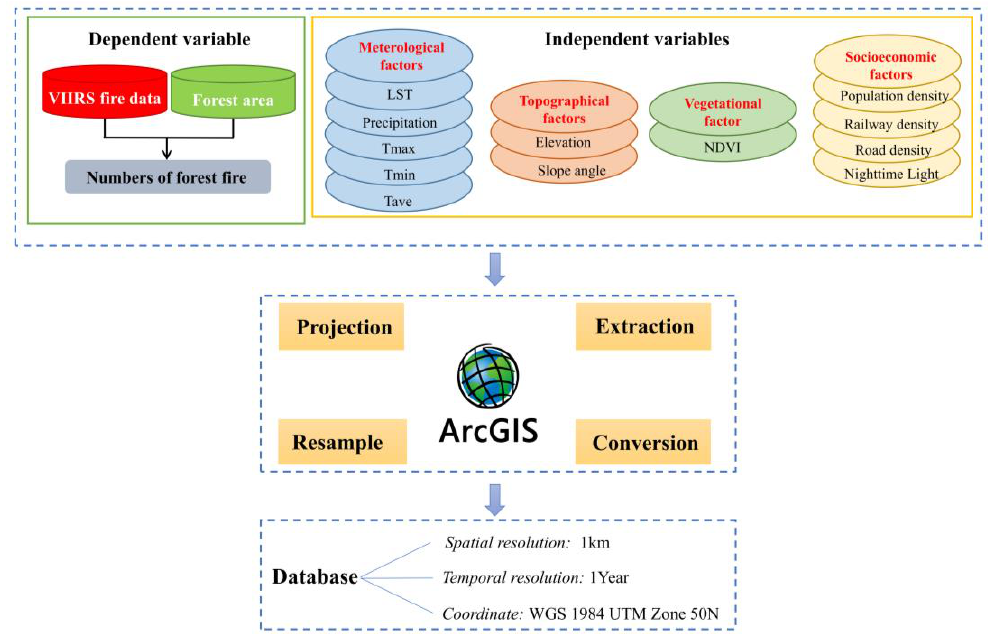
Figure 2. Data processing workflows.